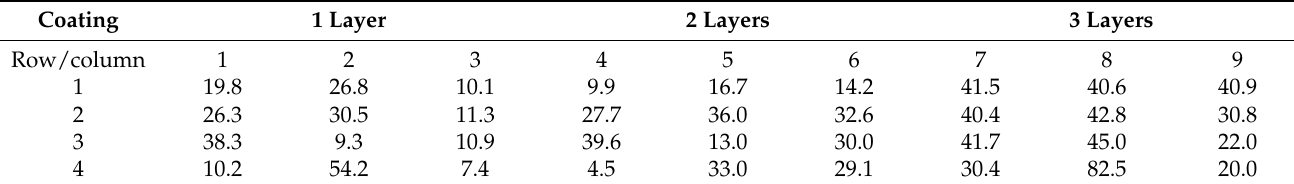
Table 4. Comparison of phase-shift angles ϕ 0.1 ( ◦ ) at 36 test points on the large steel sheet with the blue coating at a measurement frequency of 0.1